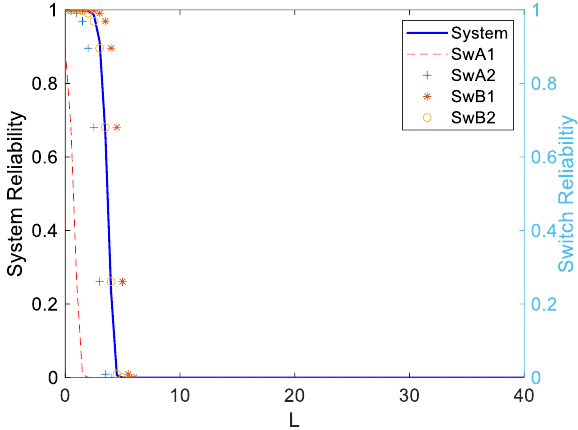
Figure 9. Set 3 in Table 6 ( L SwA10 = 5 , L SwA20 = 3 , L SwB10 = 1 , L SwB20 = 2 , and α i